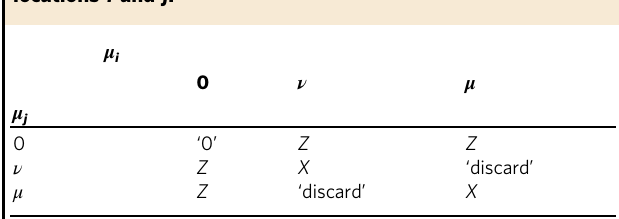
Fig. 5 The quantum operations and usage of Alice ’ s encoding states on two paired locations (1, 2). There are 8 systems based on Alice's two paired locations. Among them, the two qudits ~ A 1 and ~ A 2 are measured to obtain the overall photon number k a and the relative phase θ a of two optical modes A 1 and A 2 . The two qubits A 00 and A 00 are measured to obtain the relative phase, which is the raw key bit in the X -basis. Another two qubits A 0 1 2 measured to obtain the encoded intensity in A 1 and the relative encoded intensity, which are used for the key mapping on the Z -basis and the basis assignment, respectively. Table 2 Alice ’ s (or Bob ’ s) basis assignment on the paired locations i and j .